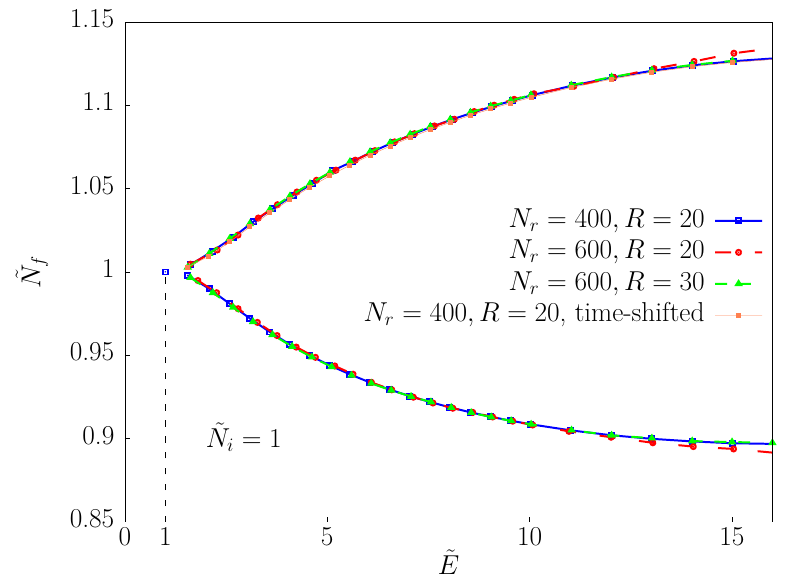
Figure 6 . The classically allowed region in ( ~ E; ~ N f ) plane for ~ N i = 1 calculated for three cases: 1) N r = 400 ; R = 20; 2) N r = 600 ; R = 20; 3) N r = 600 ; R = 30; 4) N r = 400 ; R = 30, time-shifted solutions (see main text for details) . The space intervals chosen for selection of the initial wave packets are presented in the main text.